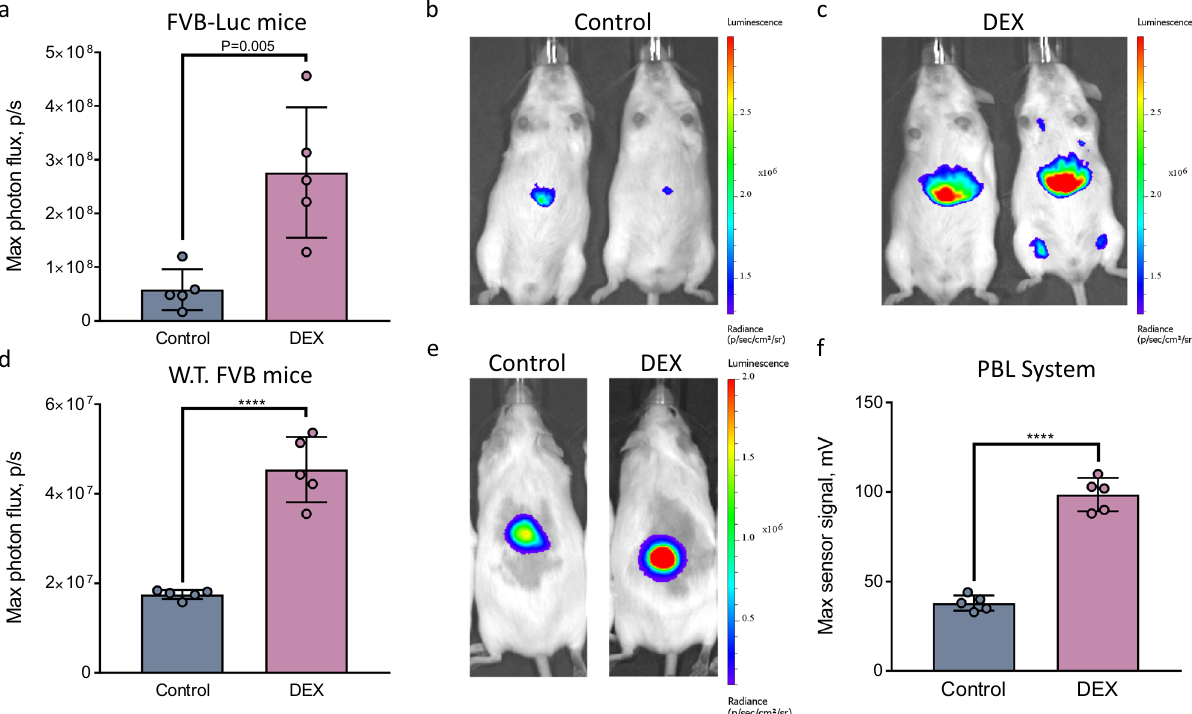
Fig. 4 Noninvasive in vivo measurements of intracellular enzymatic activity of CYP450: direct comparison of stationary CCD camera (IVIS ® Spectrum) and PBL readouts. a Maximal photon fl ux resulting from two groups of FVB-luc + / + mice ( n = 5) injected with the Luciferin-IPA TM probe, a caged luciferin reagent speci fi cally designed to measure activation of the Cyp3a isozyme of CYP450 45 . The “ DEX ” group of mice was treated with dexamethasone, a known activator of Cyp3a, 24 h prior to the injection with the Luciferin-IPA TM probe, while the control group received a gavage of vehicle only (vegetable oil). The light output was measured with the IVIS ® Spectrum. b – c Representative images of two mice from the control ( b ) and DEX-treated ( c ) groups. d Maximal photon fl ux obtained from two groups of wild-type non-transgenic FVB mice ( n = 5) injected i.p. with the Luciferin-IPA TM probe followed by injection of the luciferase plug (s.c. in the dorsal area) and subsequent imaging by the IVIS ® Spectrum. Analogous to the experiment described in ( a ), the “ DEX ” group of mice was treated with DEX 24 h prior to the injection with the Luciferin-IPA TM probe while the control group received the gavage of vehicle only. The light output of the plug was measured with the IVIS ® Spectrum. e Representative mouse images from the control and DEX-treated groups in the experiment described in ( d ). f Maximum signal output from the experiment described in ( d ) except that the measurements were performed using the portable light detector. Data are presented as the mean ± s. d. ( n = 5). Each “ n ” represents a biologically independent sample. Statistical signi fi cance (**** P < 0.0001) was calculated using a two-tailed unpaired t -test. Source data is available as a Source Data fi le for ( a , d and f